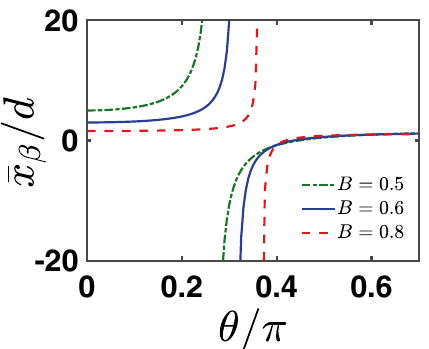
p f / p of the PSA and = ¯ f